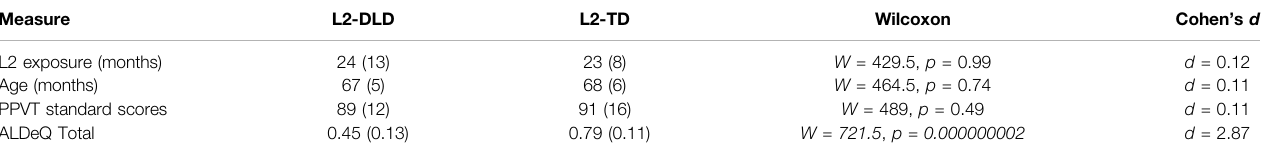
TABLE 1 | Groupwise matching of TD and DLD groups based on age, exposure, L2 vocabulary and ALDeQ score. Measure L2-DLD L2-TD Wilcoxon Cohen ’ s d L2 exposure